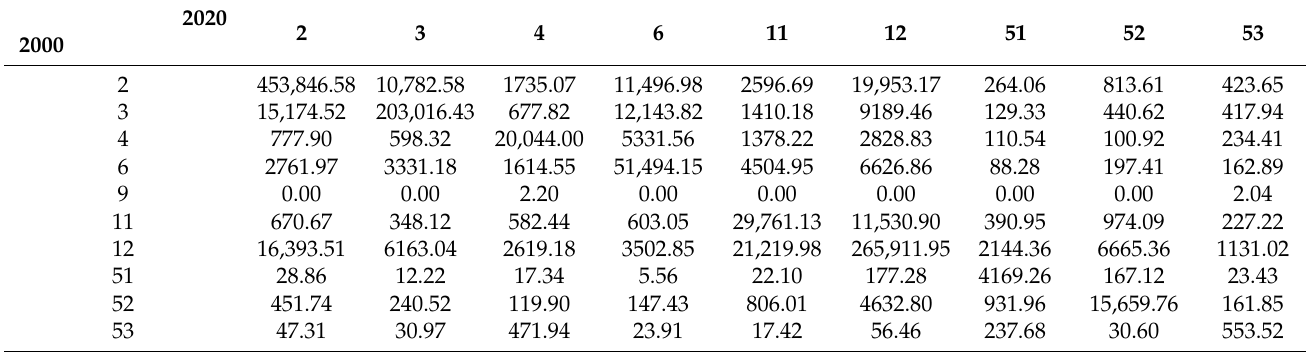
Table 3. Land use type area conversion table from 2000 to 2020